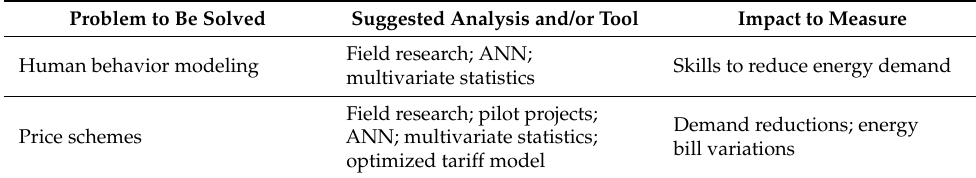
Table 5. Problems, suggestions, and impacts of demand response and dynamic pricing. Source: own